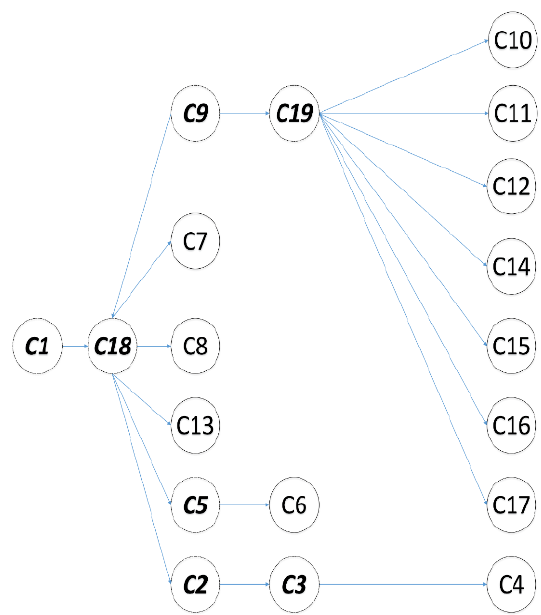
Figure 7. Expansion algorithm. The points with bold italic numbers are expansion points.